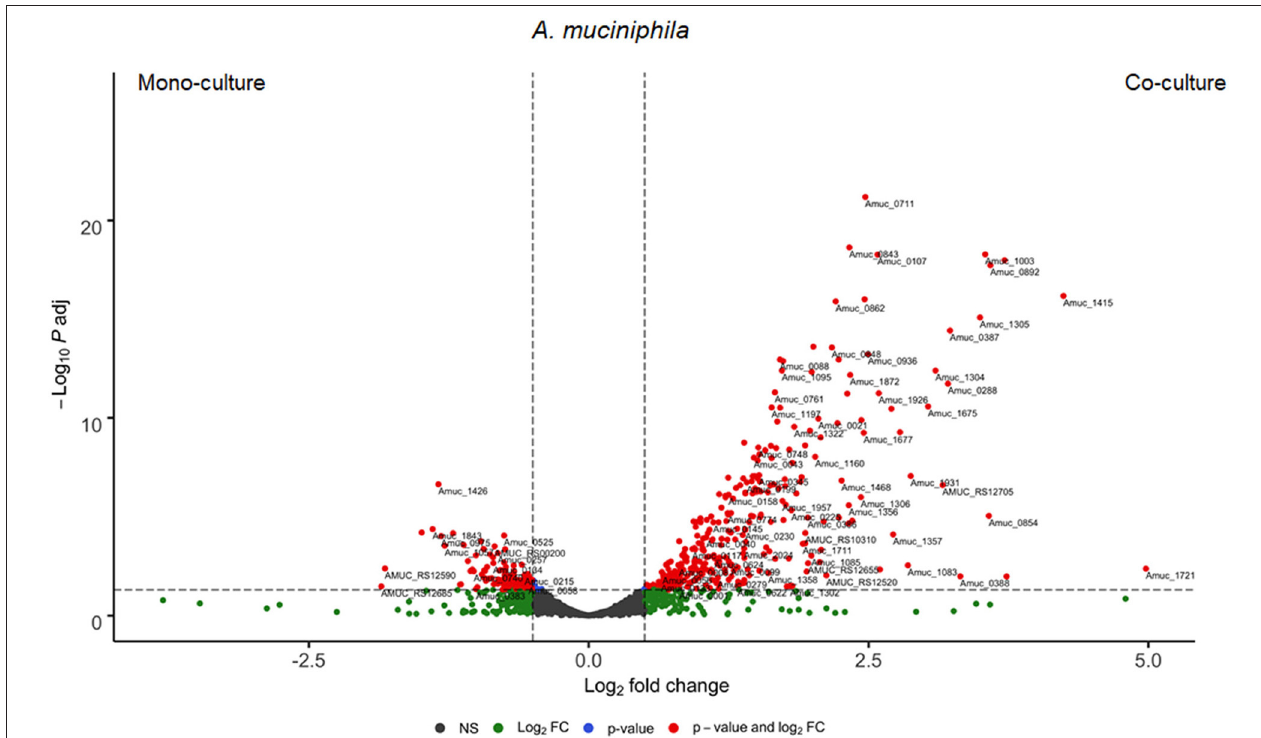
FIGURE 5 | Differential expressed genes of A. muciniphila between mono- and co-culture during in vitro fermentation. Volcano plot of the differential expressed A. muciniphila genes of mono- vs. co-culture. Positive Log2 fold change indicates upregulation in co-culture. The horizontal dashed black line adjusted p -value threshold ( q = 0.05). The vertical dashed black lines indicate Log2 fold change threshold (Log2 fold change =